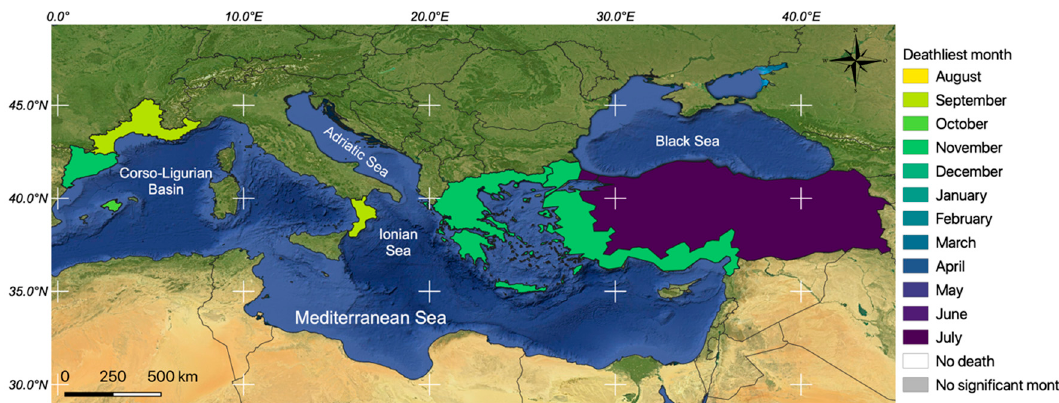
Figure 12. Deadliest month per region.